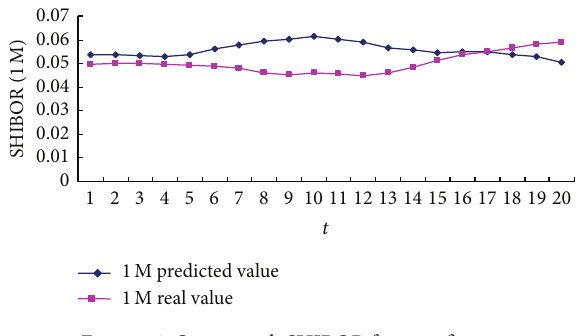
Figure 8: One-year SHIBOR forecast